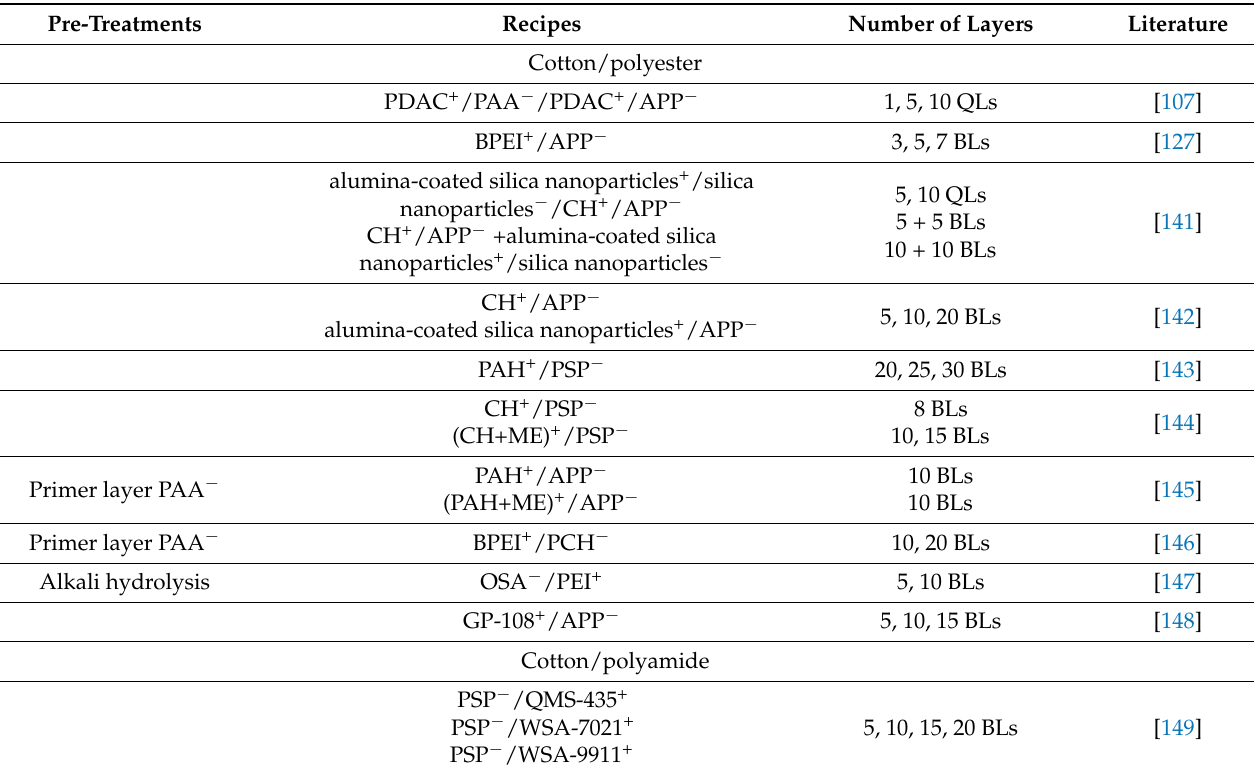
Table 5. Polyelectrolytes used to achieve FR of cotton/polyester and cotton/polyamide blends. Pre-Treatments Recipes Number of Layers